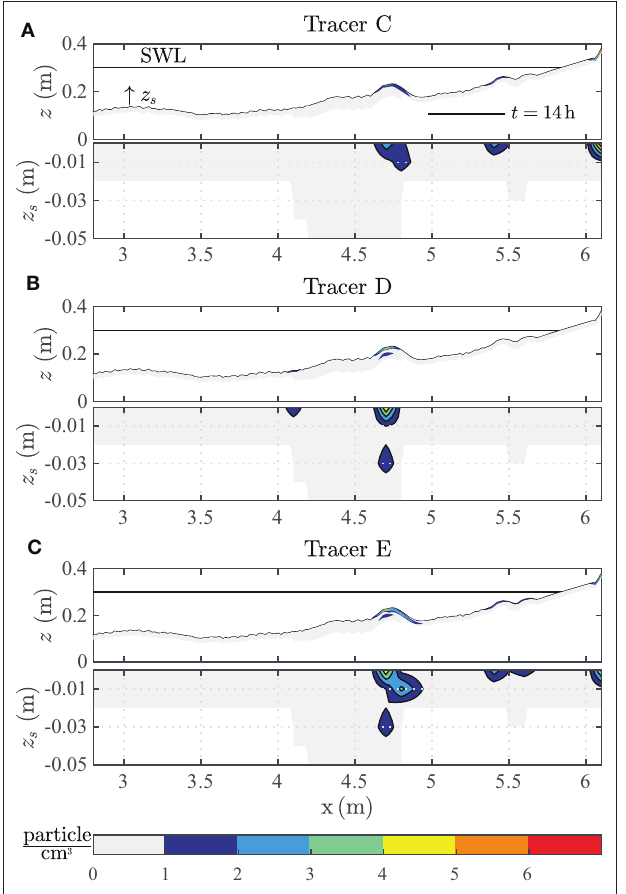
FIGURE 7 | Microplastic distribution of Tracer “E” below the beach profile surface in (A) Test 001 after 1h testing, (B) Test 001 after 14h testing and (C) the repetition Test 002 after 14h